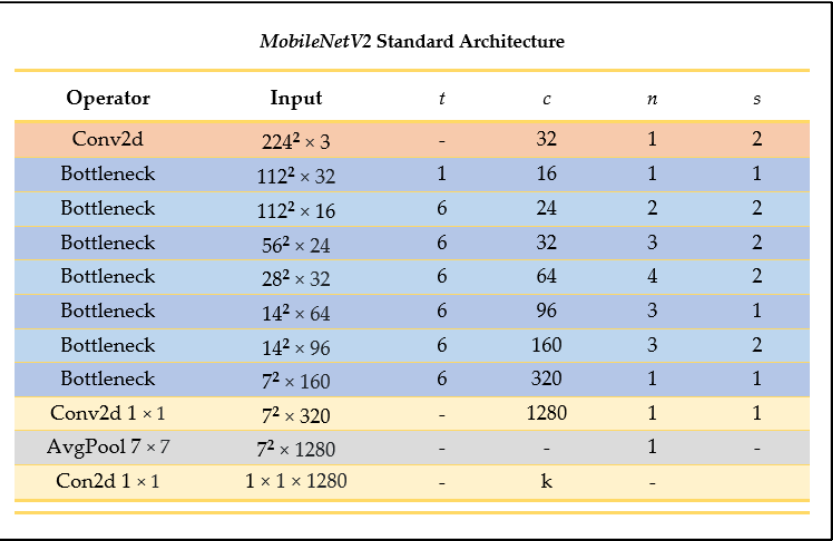
Figure 7. MobileNetV2 architecture summary (as outlined in [25]).